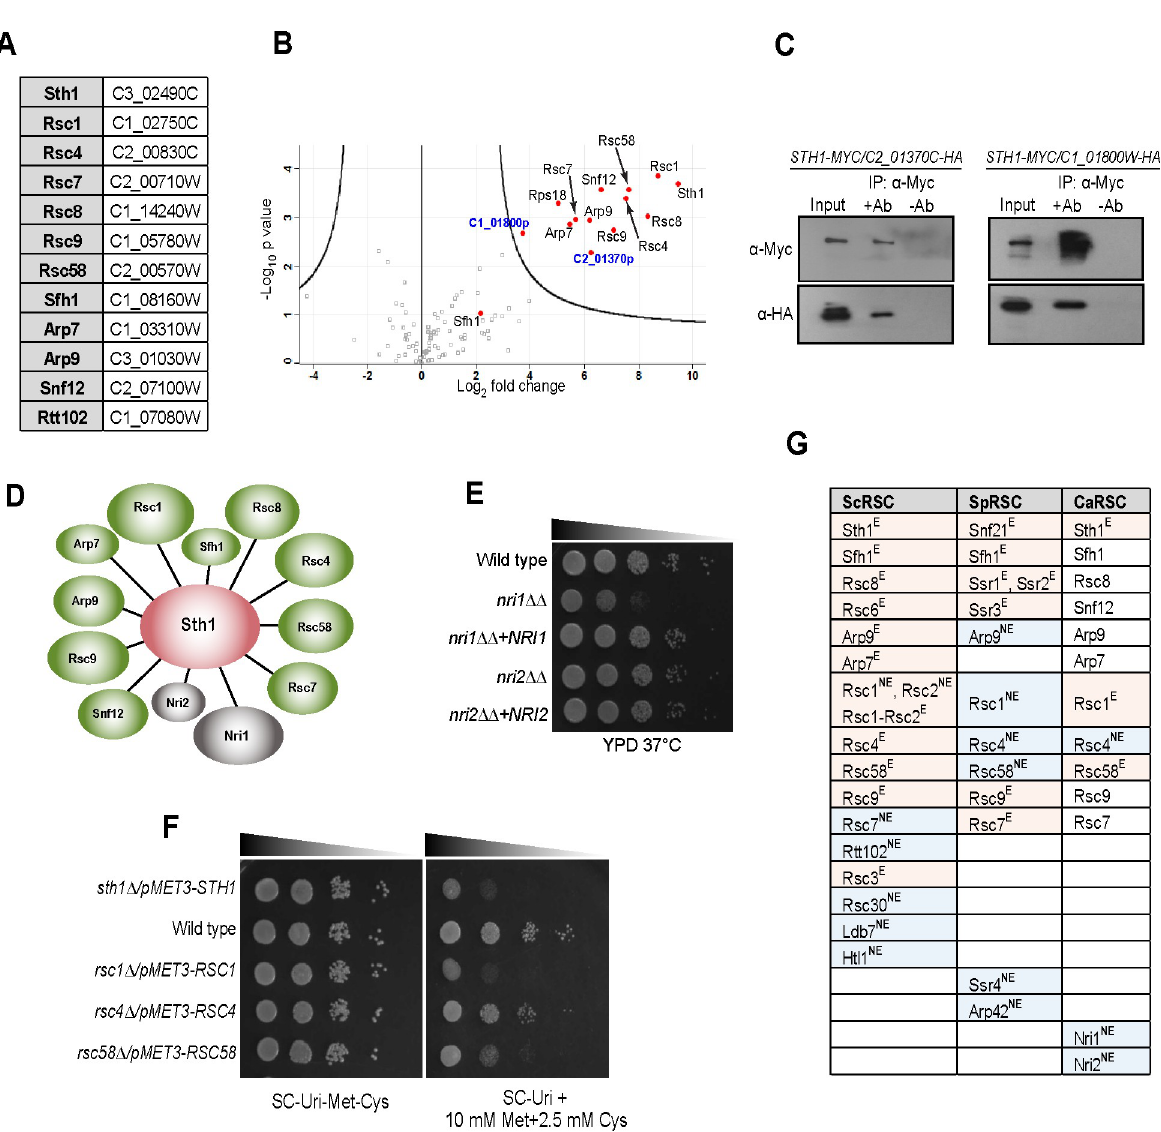
Fig 1. The C . albicans RSC complex is compositionally and genetically distinct from RSC of model yeasts. A. List of putative RSC subunits and their respective ORFs in C . albicans predicted from the Candida Genome Database. B. Volcano plot representation of significantly enriched proteins that copurified with Sth1-Myc (SGC2003) compared to a no-tag control (SGC2006). Significant interactors identified are shown on the right side of the parabola as red dots, except for one potential interactor with low confidence score (Sfh1), highlighted on the left side. The grey boxes represent the potential background interactors. The two novel interactors are labelled in blue. The x-axis denotes the enrichment of the interaction in Sth1-Myc samples with respect to no-tag control, represented as a natural logarithm of normalized intensity values. The negative logarithm to the base 10 of the p-value, based on Student’s t- test, is given on the y-axis. C. Cell lysates from cells expressing Sth1-Myc and C2_01370p-HA (SGC2043) or Sth1-Myc and C1_01800p-HA (SGC2044) were immunoprecipitated with the polyclonal anti-myc (ab9106) antibody. Sth1-Myc and C2_01370p-HA or C1_01800p-HA were detected by immunoblotting using monoclonal anti-Myc (9E10) and anti-HA (3F10) antibodies respectively. Two percent of input and 50% of eluate were loaded. Uncropped images of blots shown here are presented in S8 Fig. D. Schematic model of the C . albicans RSC complex based on AP-MS of Sth1-Myc. Sth1, the catalytic RSC component is shown in red, while the conserved subunits and the newly identified interactors are shown in green and grey, respectively. The size of the ellipses approximately represents the size of the respective proteins. The length of the lines connecting Sth1 to other RSC subunits are drawn arbitrarily. E. Growth of wild type (SGC2024), nri1 ΔΔ (SGC2047) and nri2 ΔΔ (SGC2032) mutants, and their corresponding re-integrant ( nri1 ΔΔ + NRI1 :SGC2049; nri2 ΔΔ + NRI2 : SGC2036) strains on YPD plates, incubated at 37˚C and photographed after 24 hours. F. Essentiality of pMET3 -based conditional RSC mutants of C . albicans ( MET3-STH1 :SGC65; MET3-RSC1 :SGC2070; MET3-RSC4 :SGC2053; MET3-RSC58 :SGC2075). Serial dilutions of the indicated strains were spotted on growth permissive (SC-Uri-Met-Cys) and repressive (SC-Uri+10 mM Met+2.5 mM Cys) plates and incubated at 30˚C for 2 days. Since these strains were constructed in SN148 background using URA3 marker, SN148- URA3 (SGC2006) was used as the wild type control. G. Comparison of RSC composition and subunit essentiality (E-essential and NE-non-essential colored in red and blue respectively) in S . cerevisiae , S . pombe and C . albicans